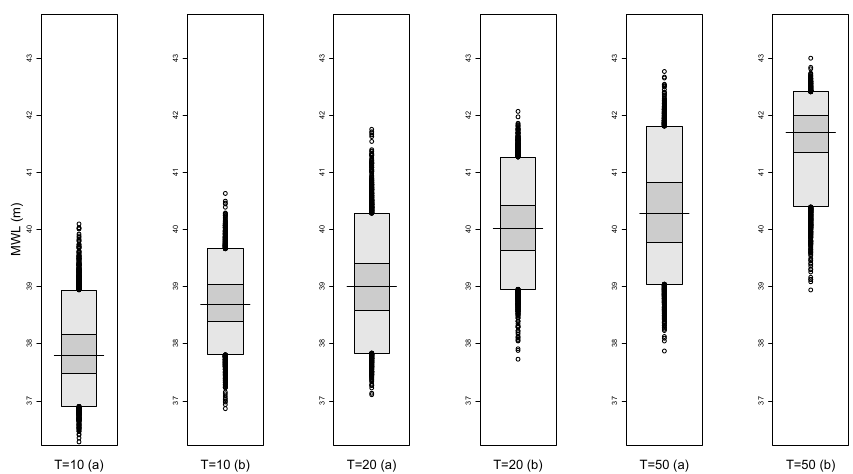
Figure 7. High-density region box plots of MWL for return periods of 10, 20 and 50 years for (a) single-site data and (b) multi-site data with historical information.